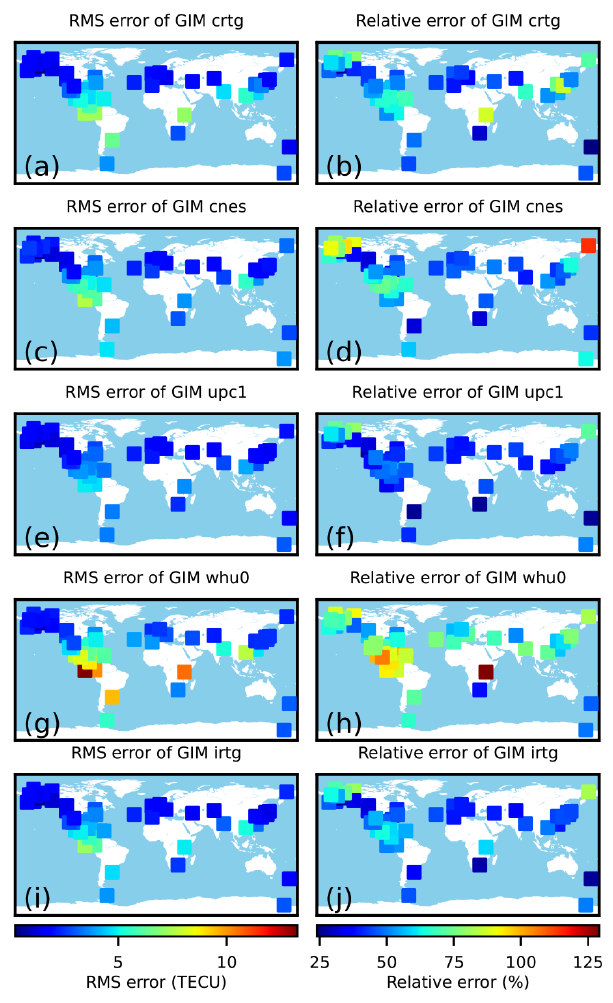
Figure 4. The distribution of dSTEC-GPS results on 5 Jan- uary 2021 (after the improvement of the UPC interpolation tech- nique).